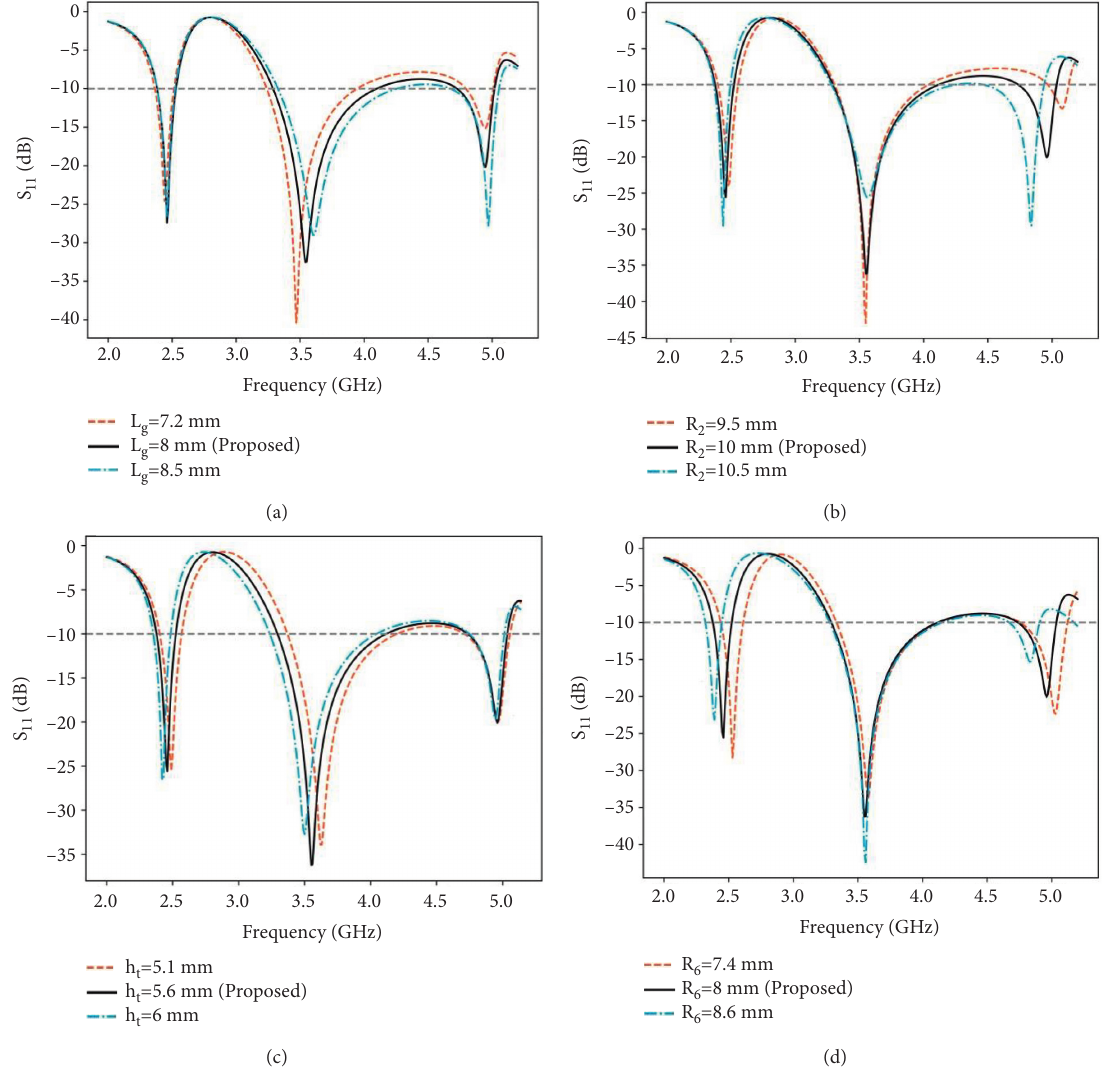
Figure 4: Simulated reflection coefficients S